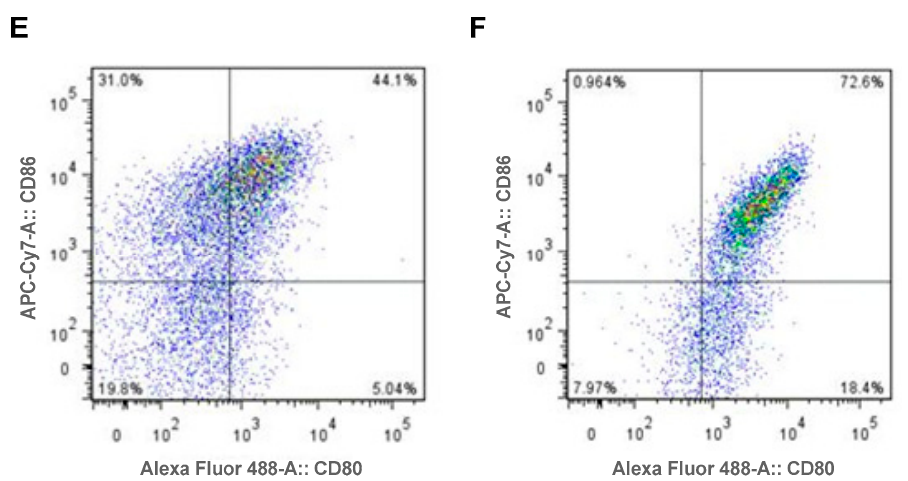
Figure 1. TLR9 ligation enhances MPO pulsed dendritic cell activation upregulating dendritic cell CD40 and CD80 expression. For fluorescence-activated cell sorting analysis, gates were set based on the mean fluorescence intensity for single color negative controls. ( A , B ): DCs assessed following rmMPO and TLR9 ligand, CpG incubation; Viability ( A ) and Cell Specificity ( B ). ( C , D ): DCs assessed following recombinant mouse MPO (rmMPO) and Control, GpC ( C ) and TLR9 ligand, CpG ( D ); Assessment of cell surface activation markers MHCII and CD40. CD40 expression was higher in rmMPO/CpG incubated DCs (91% CD40 hi ) compared to rmMPO/Control incubated DCs (44% CD40 hi ). MHCII expression was unchanged between DC groups (( D ):72% vs. ( C ):79%). ( E , F ): DCs assessed following rmMPO and Control, GpC ( E ) and TLR9 ligand, CpG ( F ). Assessment of cell surface activation markers CD86 and CD80. CD80 expression was higher in rmMPO/CpG incubated DCs (91% CD80 hi ) compared to rmMPO/Control incubated DCs (39% CD80 hi ). CD86 expression was unchanged between DC groups (( F ): 74% vs. ( E ): 75%). DC = Dendritic cell, PI = Propidium iodine.